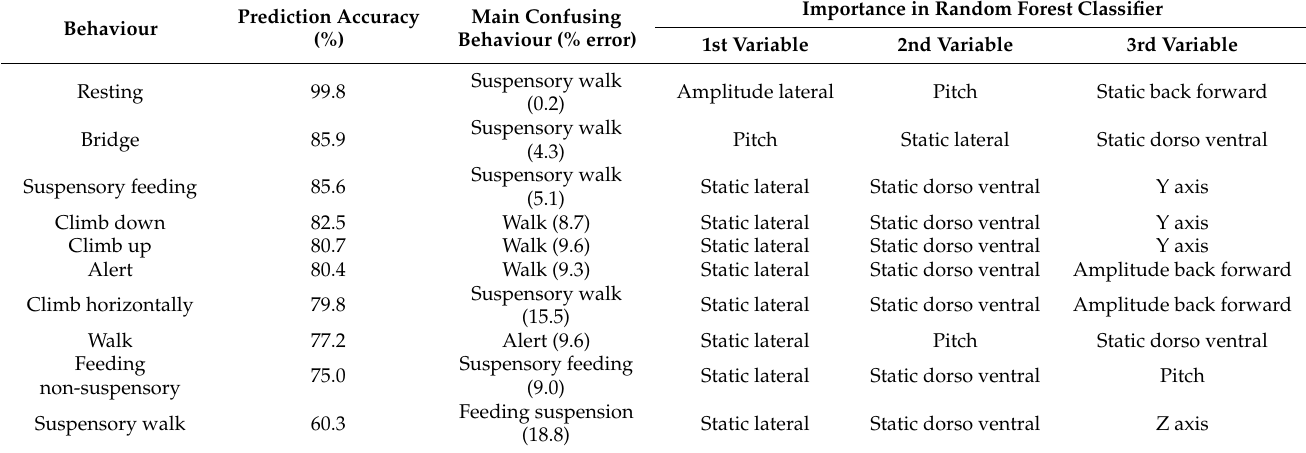
Table 3. Results of the random forest classification to assess the predictive power of the variables retrieved from a three-axis accelerometer in assessing the behaviours of a captive Bengal slow loris. Prediction accuracy and main confusing behaviour were based on the performance of the random forest model obtained from the training set of data in predicting the behaviours in the validation set. The importance in random forest classifier was based on the training